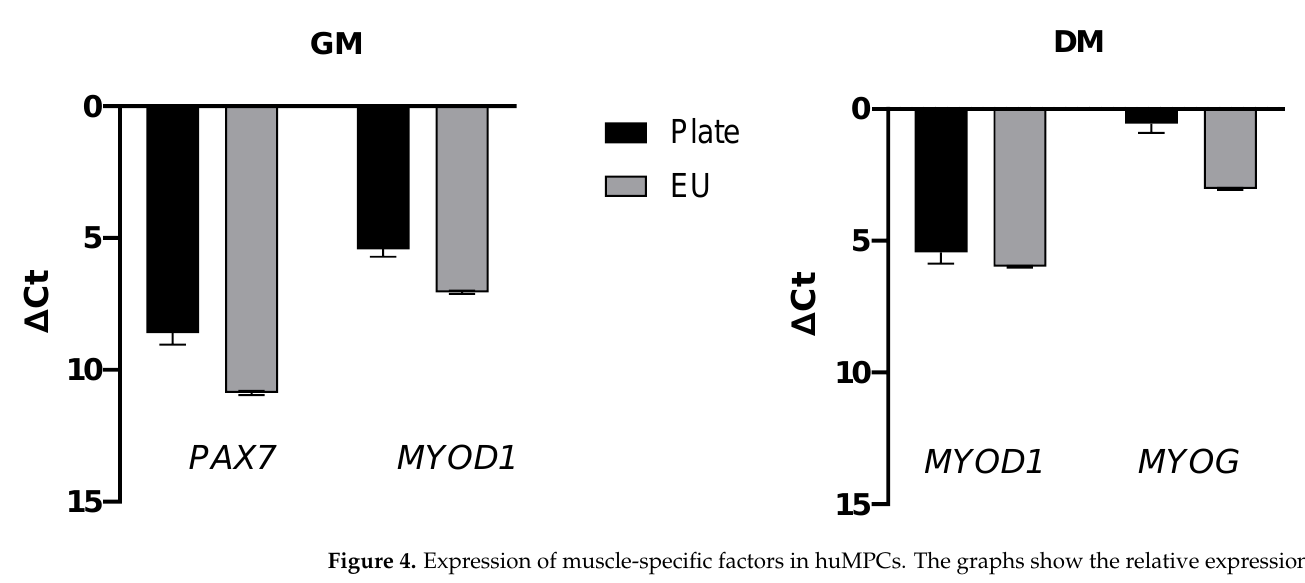
Figure 4. Expression of muscle-specific factors in huMPCs. The graphs show the relative expression of PAX7 , MYOD1 , and MYOG genes with respect to GAPDH in huMPCs cultured on plates or in EUs